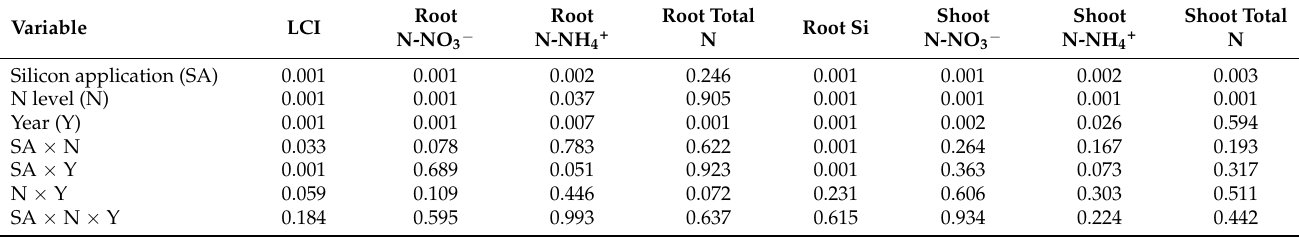
Table A2. Summary of statistical analysis ( p -values) for wheat leaf chlorophyll index (LCI) root and shoot nitrate (N-NO 3 − ), ammonium (N-NH 4+ ), total N and Si accumulation, grain total N and Si accumulation, root and shoot biomass, grain yield and agronomic efficiency (AE) affected by Si application, N level, year and their interactions.